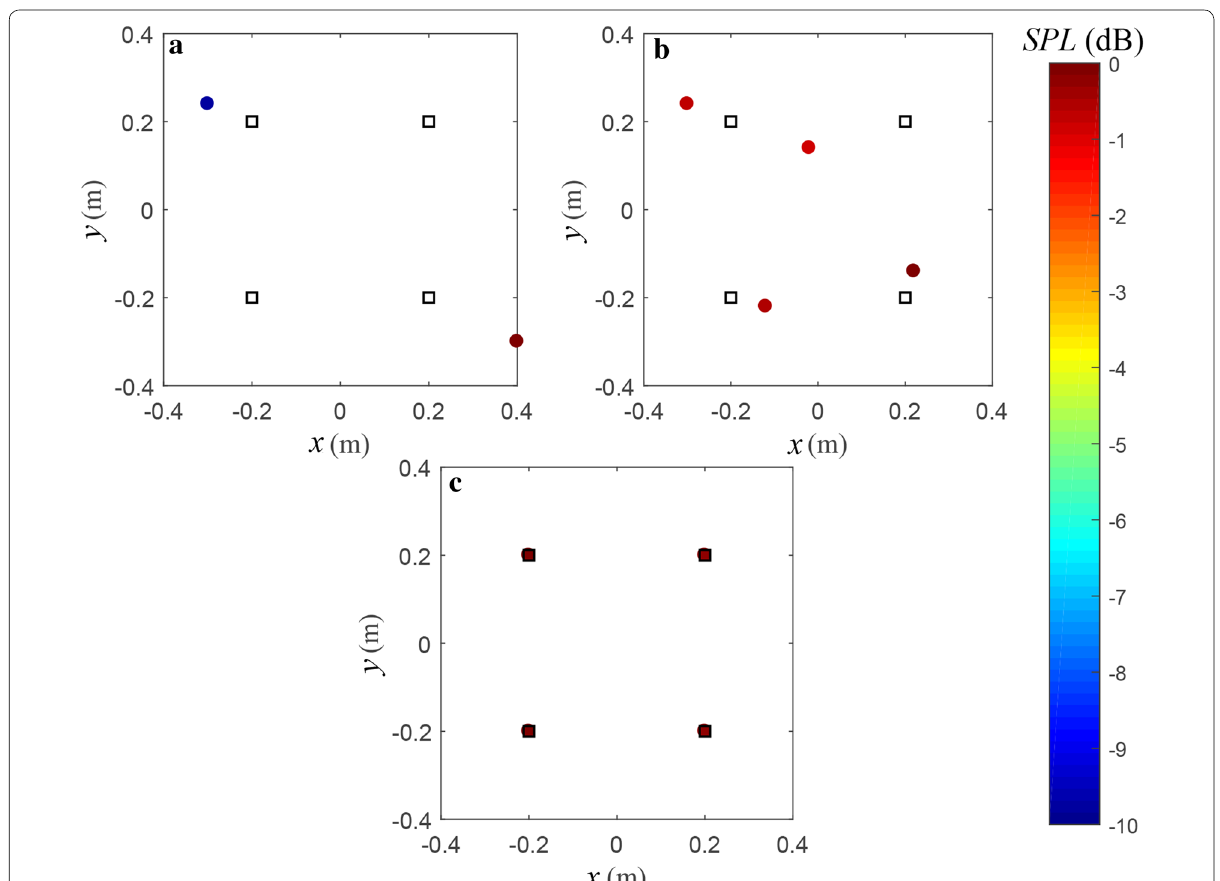
Figure 7 Source maps and the CPU-time obtained by: a Wideband BP method (129.8 s), b DCS-SOMP method (1.432 s), c DCS-SOMP-SVD method (3.242 s) when the SNR equals 20 −